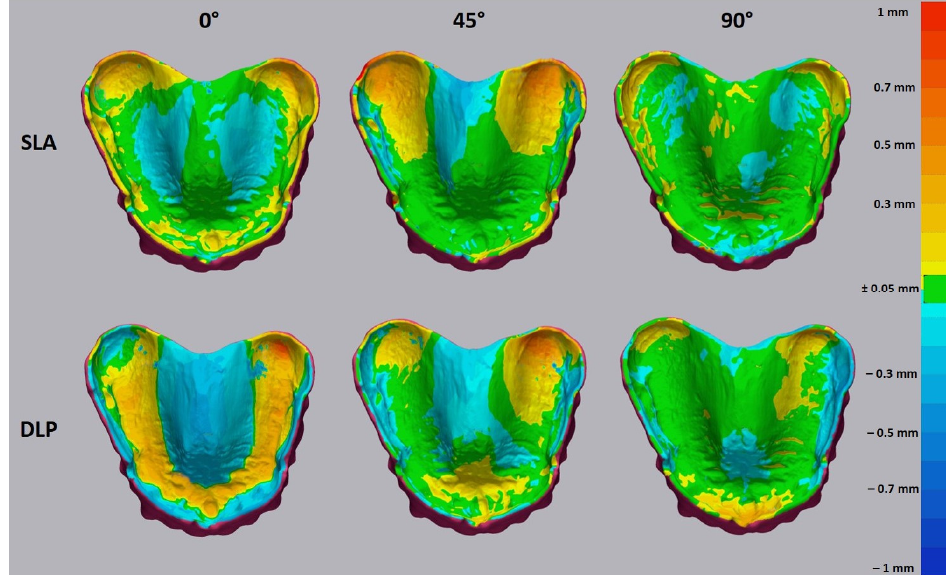
Figure 8. The heat map for the trueness of 3D printed denture bases. The tolerance level was set to ±0.05 mm. The yellow to red deviation shows the positive deviations and cyan to blue, negative.